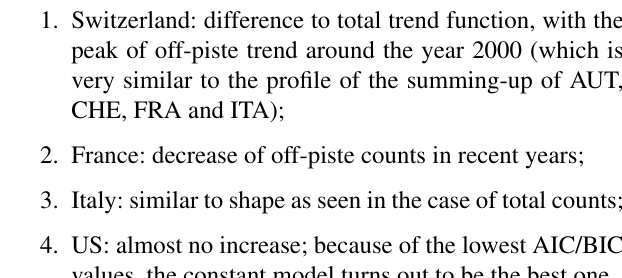
Figure 8. Observed ( ◦ ) and estimated ( avalanches (more than one fatality) with 90% confidence band (grey) in Austria within